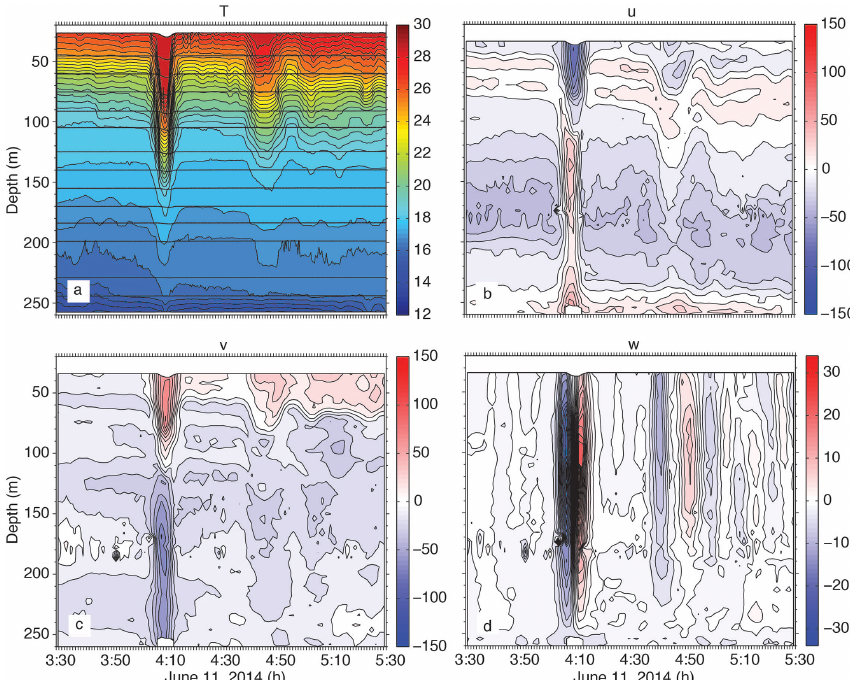
Figure 12. (a) Temperature, (b) u component of velocity (positive east), (c) v component of velocity (positive north), and (d) vertical velocity (positive up) for wave A3 on 11 June 2014. This rank-ordered packet with a symmetrical leading wave typifies most of the type-a waves observed during the